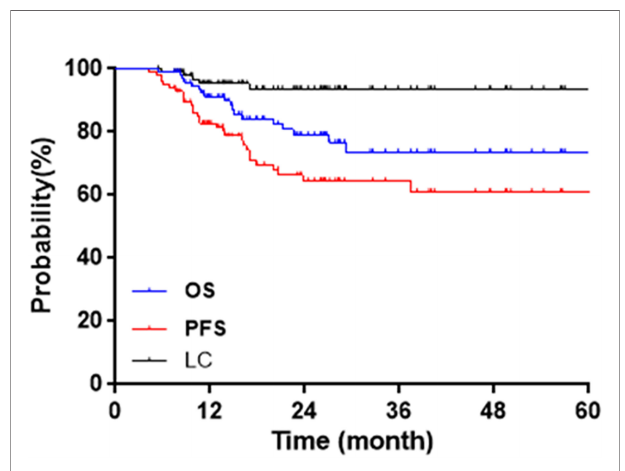
FIGURE 3 | Kaplan – Meier curves for OS, PFS, and LC.